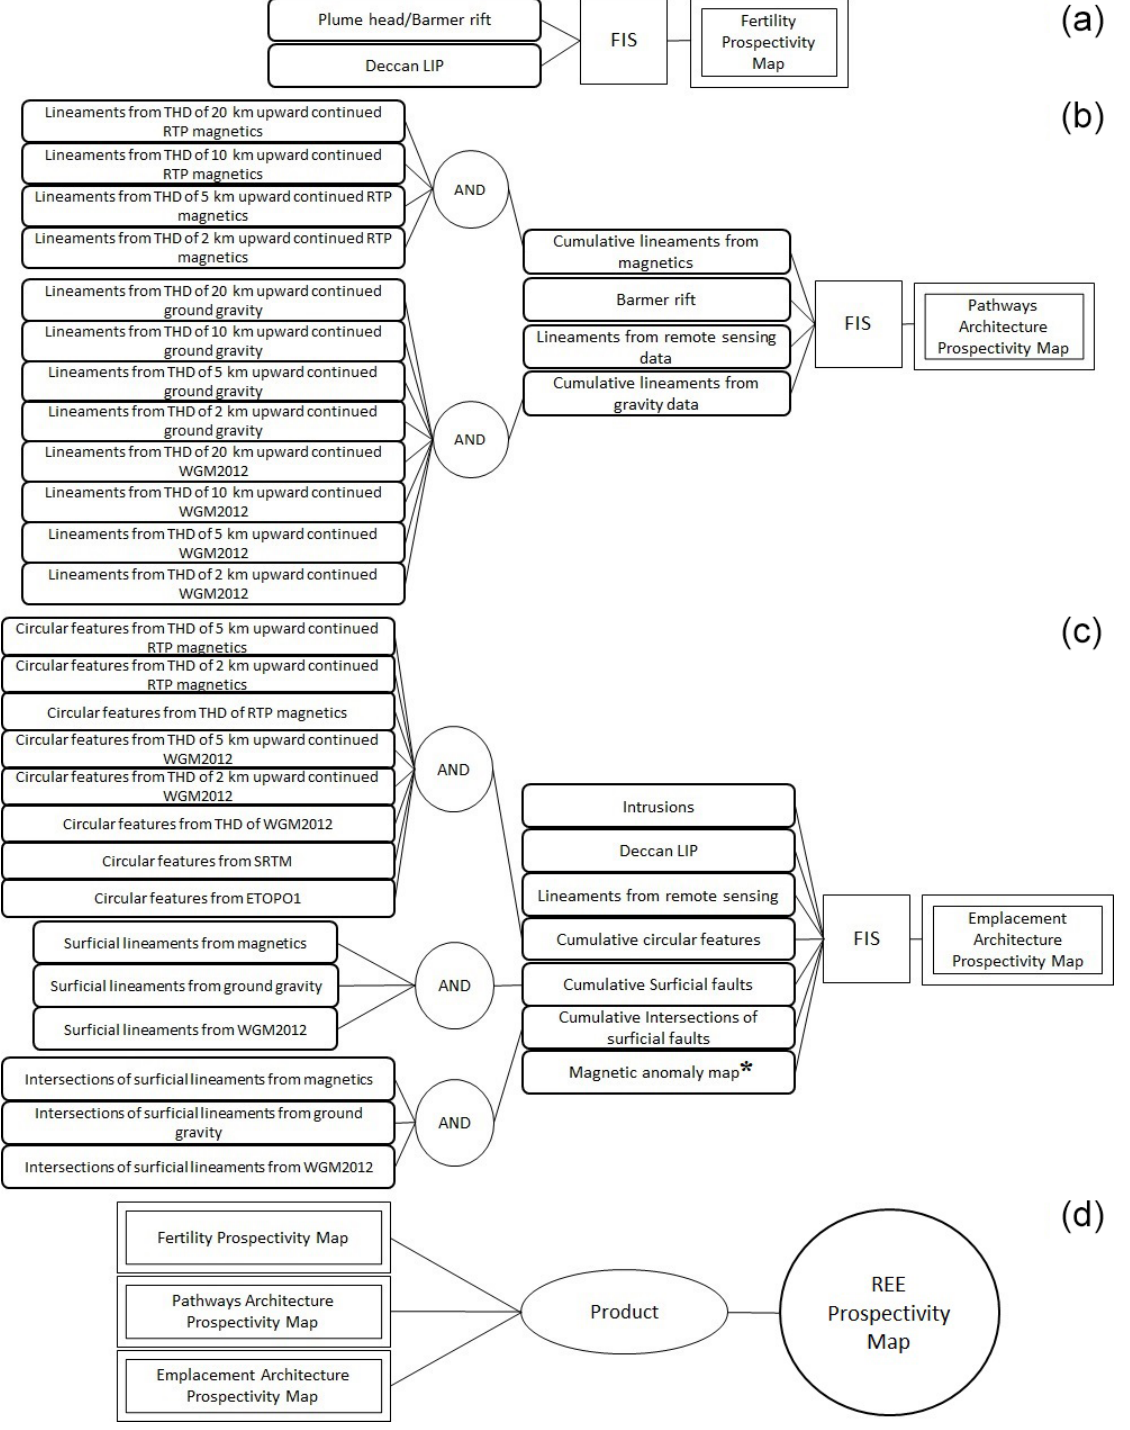
Figure 4. The multi-stage FIS for REE prospectivity mapping in the study area. (a) FIS for generating fuzzy prospectivity maps for fertile sources and favourable geodynamics settings. (b) FIS for generating fuzzy prospectivity maps for favourable lithospheric architecture for transportation of REE-enriched carbonatite–alkaline magma. (c) FIS for generating fuzzy prospectivity maps for favourable shallow crustal (near-surface) architecture for emplacement of carbonatite–alkaline complexes. (d) Second-stage FIS combines the above three prospectivity maps obtained from the first stage and generates the final outputs. ∗ All the input maps in (a–c) are Euclidean distance maps, except for the magnetic anomaly map in (c)